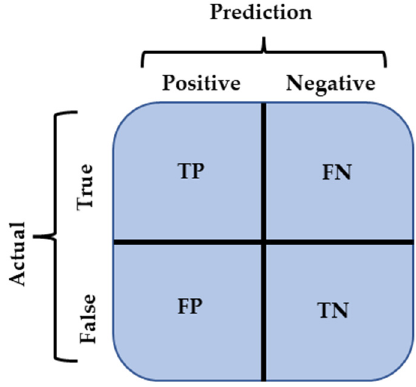
Figure 8. Model metrics judgment.